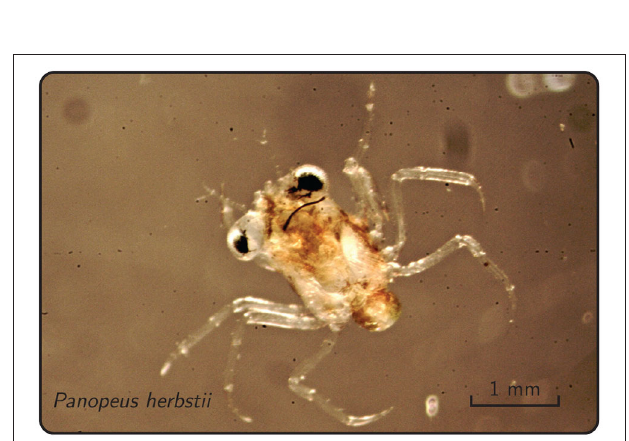
FIGURE 3 | Megalopa of the common Atlantic mud crab Panopeus herbstii